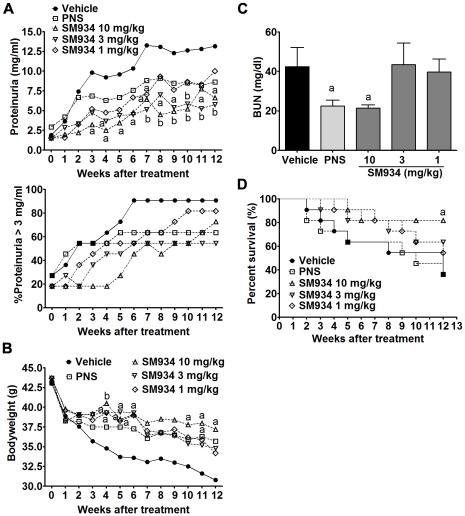
SM934 treatment for 3 months improved lupus syndroms.Six and half months old female NZB/W F1 mice were orally treated with vehicle (saline), SM934 (10, 3, and 1 mg/kg, respectively), and PNS (2 mg/kg) for 3 months (n = 11 per group). (A) Up: levels of proteinuria; Bottom: frequencies of mice with severe proteinuria (urinary protein ≥3 mg/ml). (B) Body weight. (C) Serum levels of blood urea nitrogen (BUN) immediately measured at the end of experiment. (D) Cumulative survival rate during 3 months of treatment. a = P<0.05; b = P<0.01 versus vehicle.